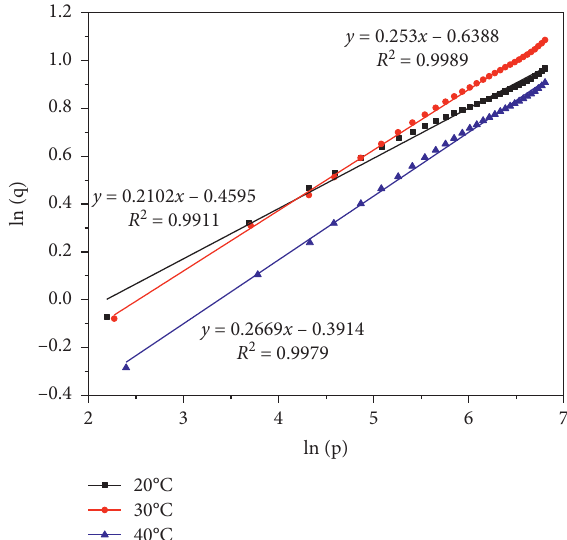
Figure 13: Relationship between of ln ( q ) and ln ( p ) on the 2CuCl/ diatomite